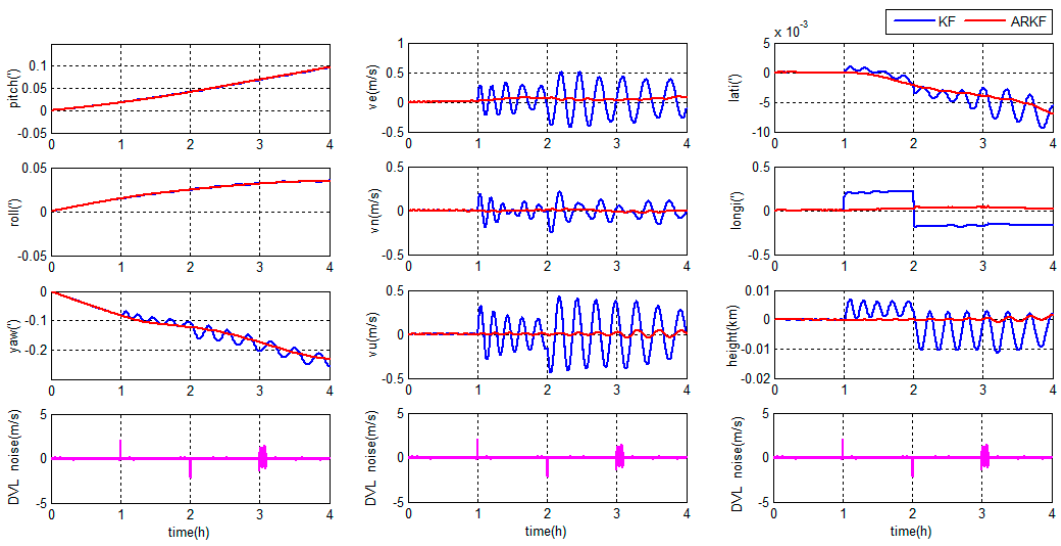
Figure 14. Integrated navigation errors in the high latitude region.